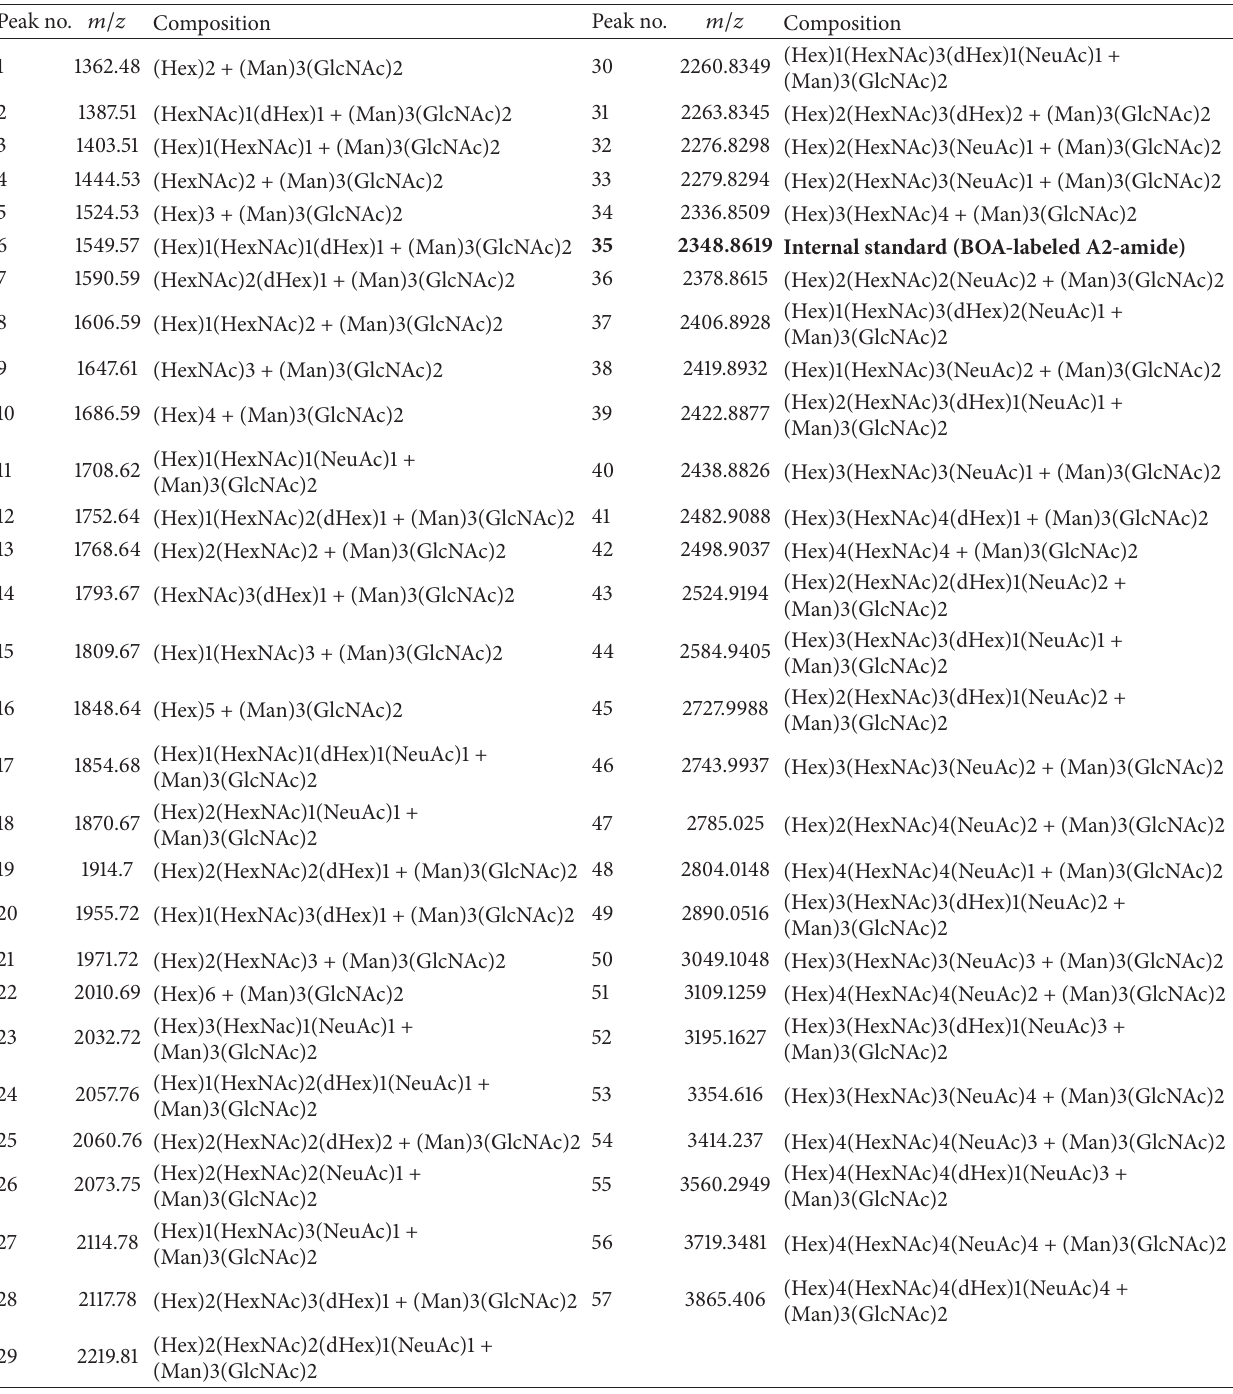
Table 1: Human serum N -glycans targeted in this